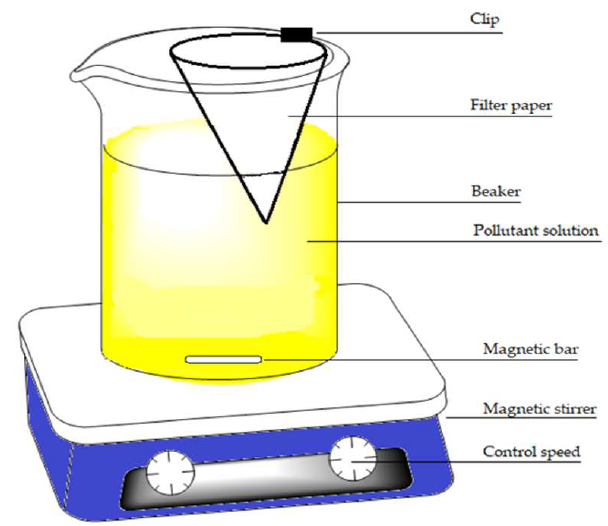
Figure 1. Diagram for the one-pot kinetic system.